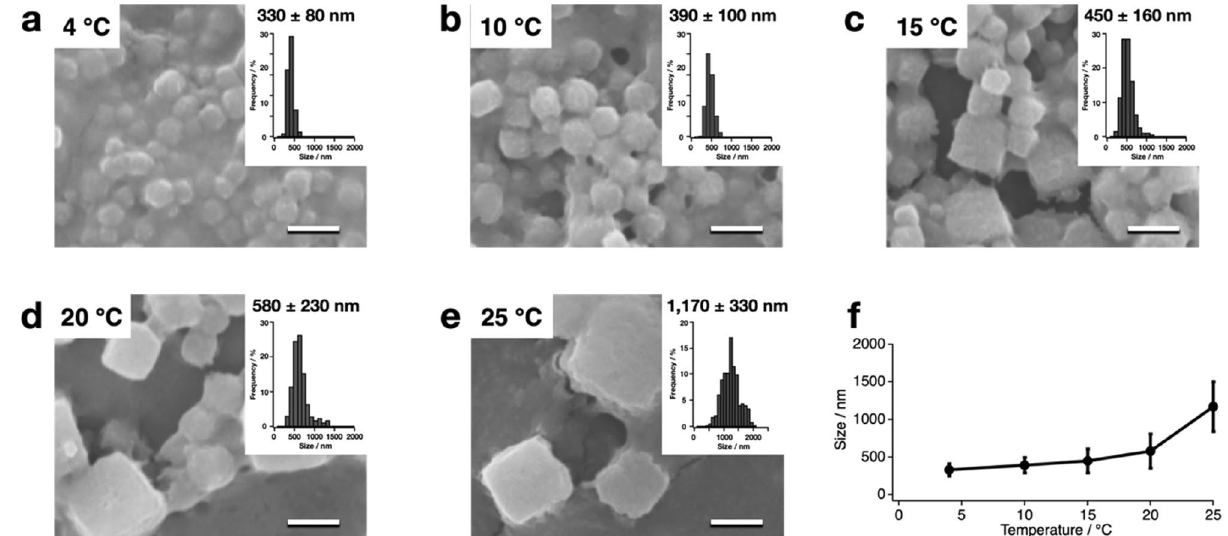
Figure 3. Temperature-dependent CFPC of PhC_CF . SEM images and size histograms of the purified PhC_CF after translation at ( a ) 4 °C, ( b ) 10 °C, ( c ) 15 °C, ( d ) 20 °C, and ( e ) 25 °C for 24 h. ( f ) Crystal size of purified PhC_CF s over temperature. Error bars = SD. Scale bars 1 μm.